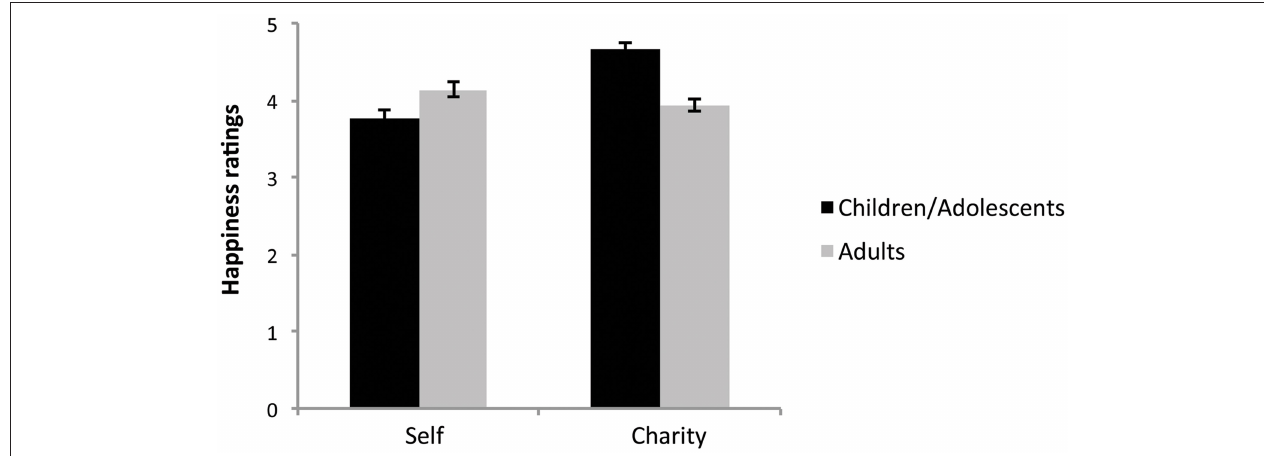
FIGURE 4 | Happiness rating for winning money for self vs. charity in children/adolescents and adults. Higher ratings indicate greater happiness reported associated with winning money. Error bars indicate standard